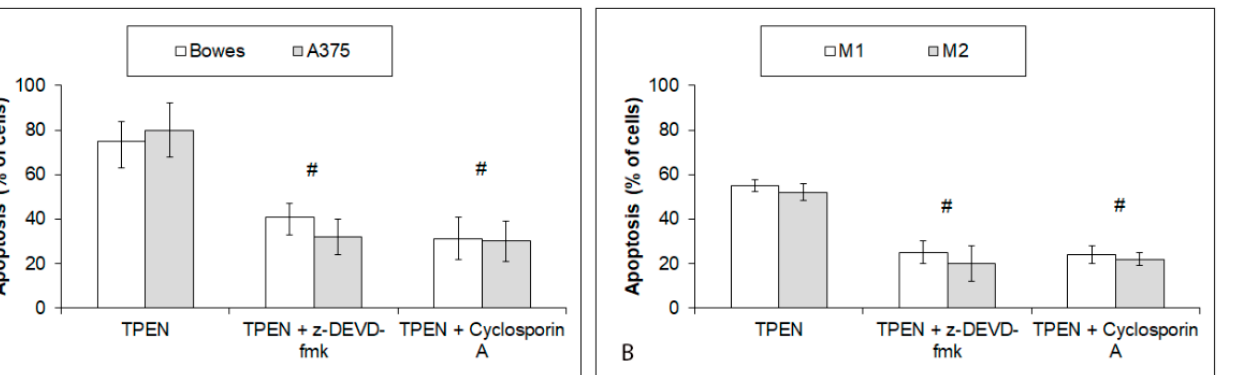
TPEN induced apoptosis of human melanoma cells during 48 h. Cells of ( A ) stabilized cell lines